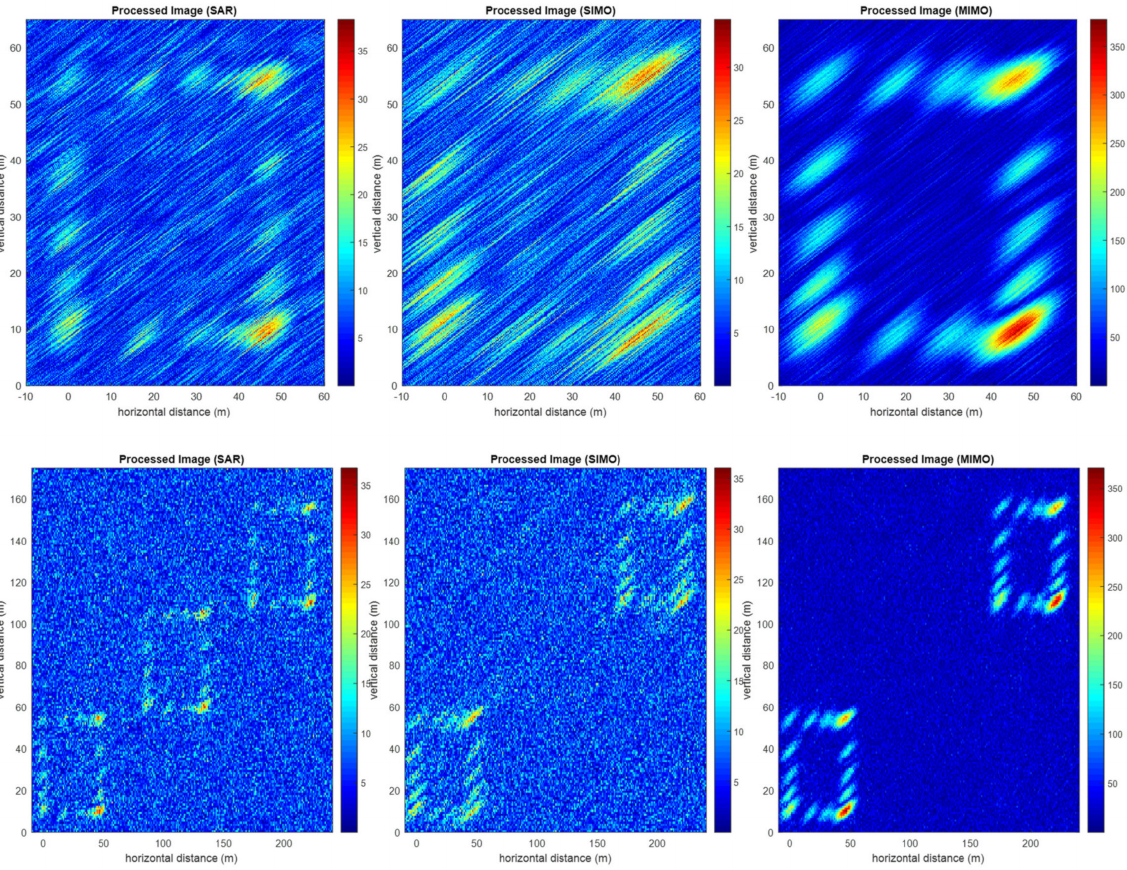
Figure 23. The simulated 2D images for Example 2 for SAR/SIMO/MIMO modes. Upper row: fine scene resolution (20 cm), small scene extent. Lower row: coarse scene resolution (1 m), large scene extent.